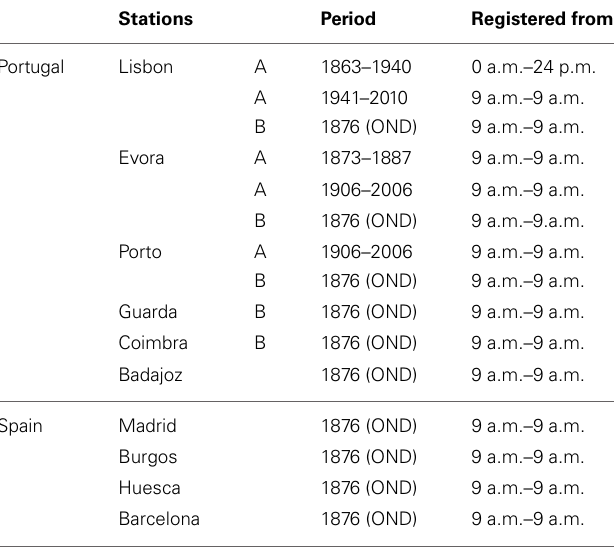
Table 1 | Available precipitation station data from Portugal and Spain.